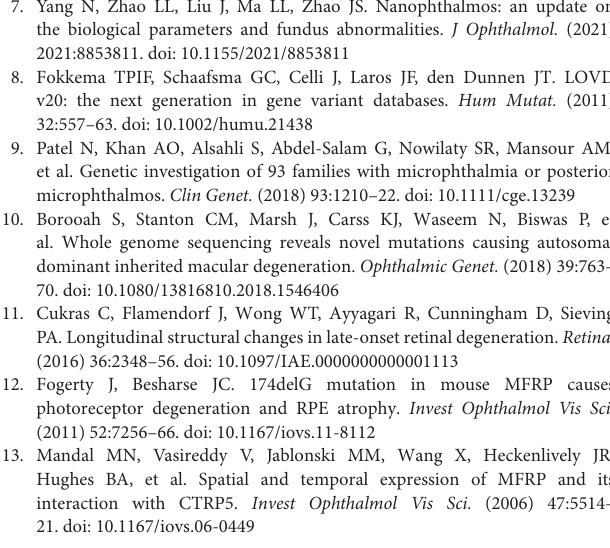
FIGURE 4 | [C.55-1 (IVS1) G > A] in MRFP for the Chinese family with congenital microphthalmia. DNA sequences of MFRP for the proband and her parents. The upper chromatogram of the DNA sequence from the affected proband (II: 2) shows biallelic A at the indicated position (red arrows). The lower two sequence chromatograms from the proband’s parents showed both A and